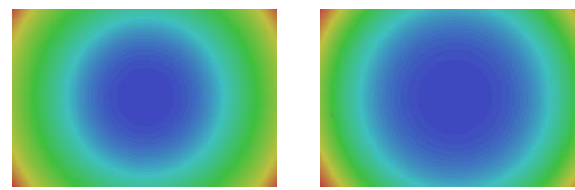
Figure 2. Interior Orientation correction visual in Adobe (left) and RawTherapee (right)